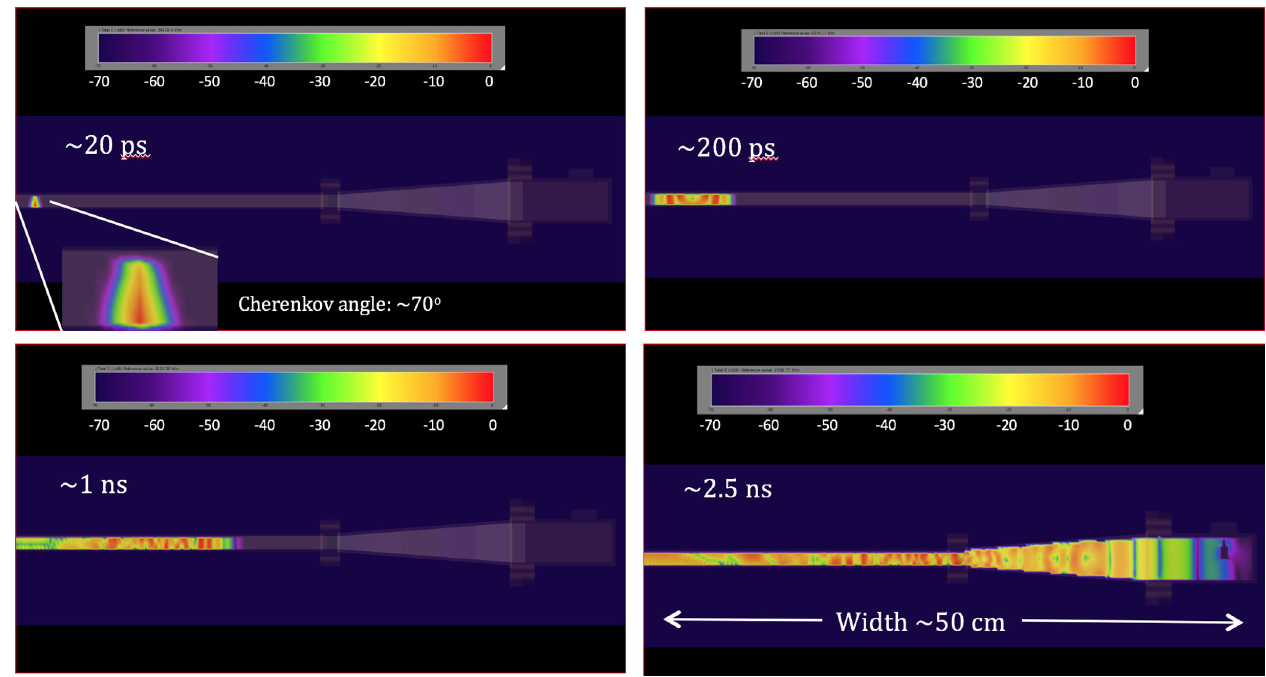
FIG. 5. Four discrete time snapshots of a cross section through one of the simulated ACE loaded waveguide elements, indexed by the time relative to the beam entry through the element. The beam transits from bottom to top. Amplitude is indicated by the color scale in dB relative to the peak amplitude.